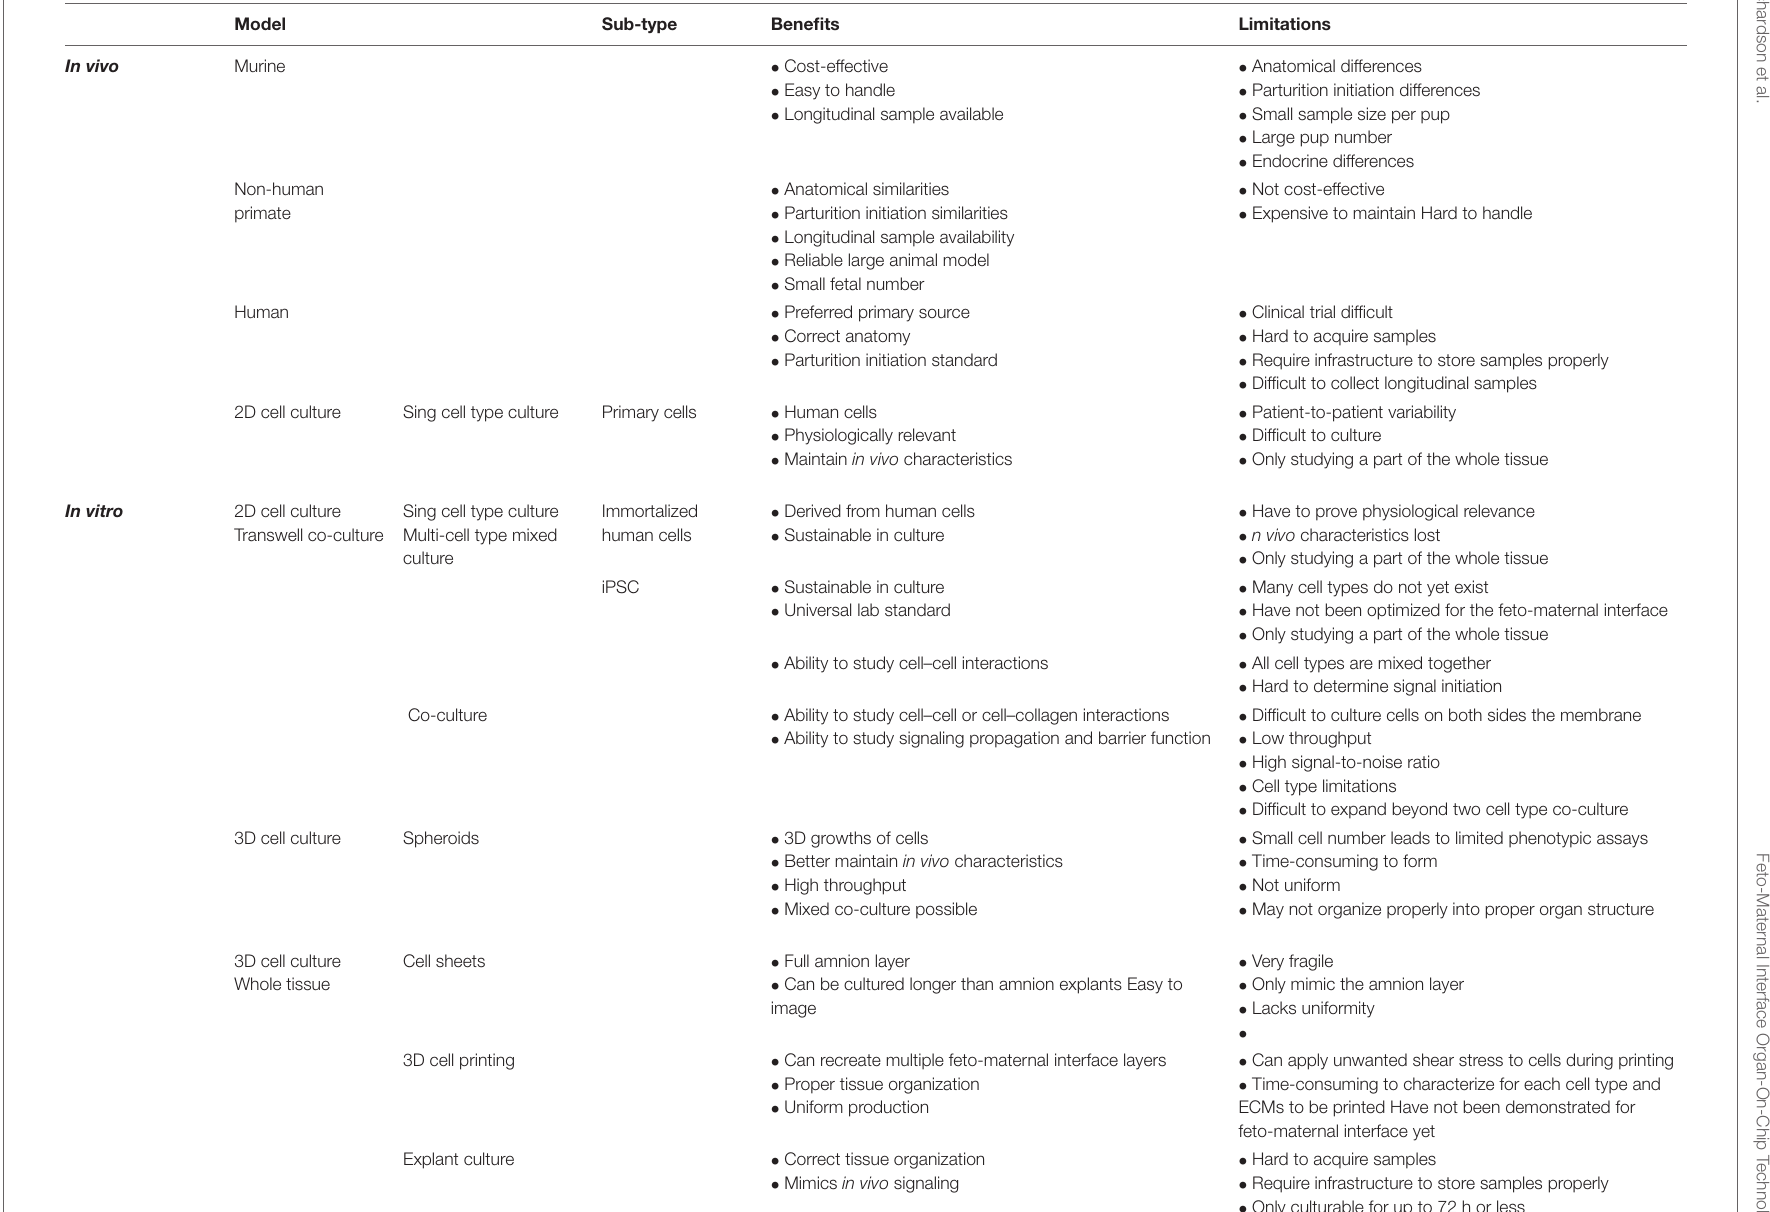
TABLE 1 | Benefits and limitation of in vivo and in vitro fetal membrane